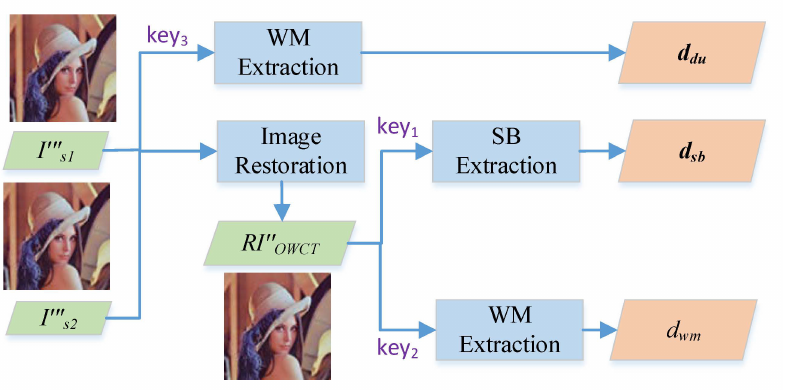
Figure 2. The flowchart of message